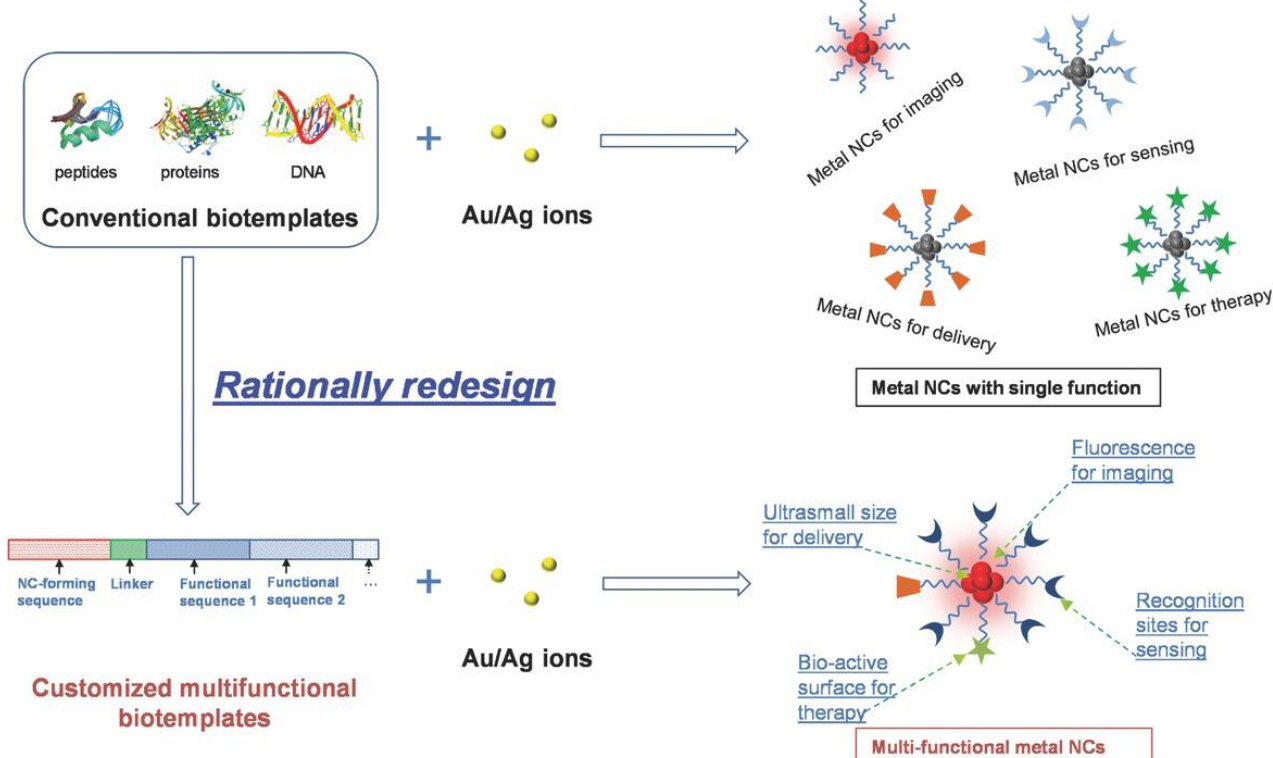
Figure 5. Peptides and metal nanoclusters (NCs) find various applications in medicine, including imaging, sensing, delivery, and therapy. Reproduced with permission from [32], © 2016 WILEY-VCH Verlag GmbH & Co. KGaA, Weinheim.